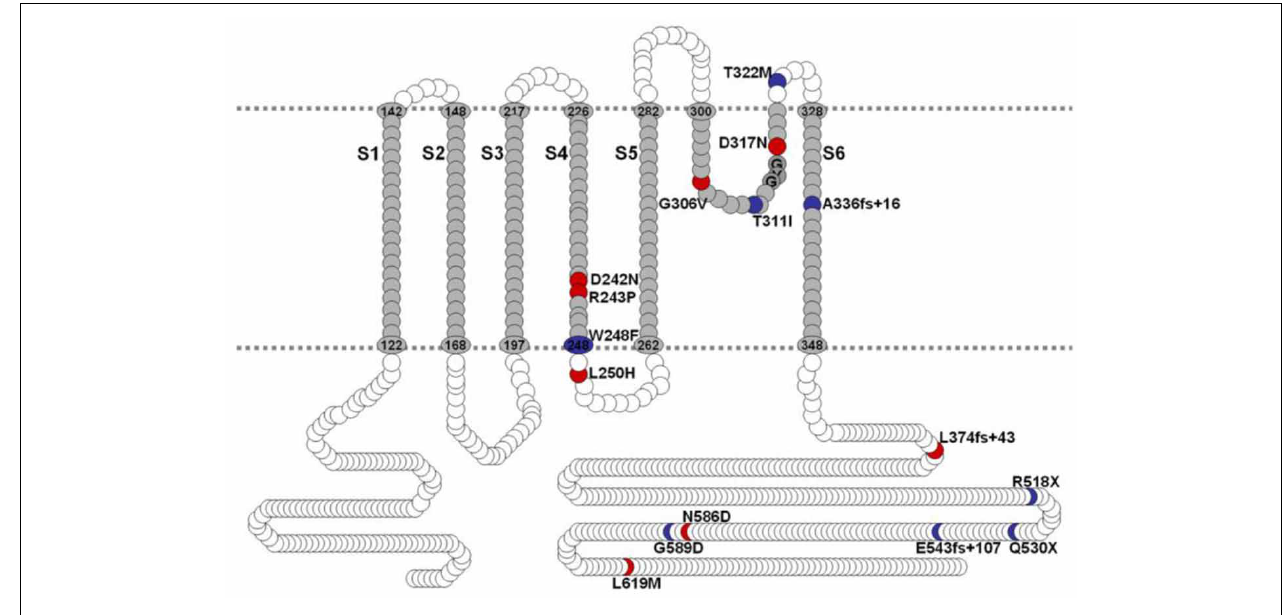
FIGURE 1 | Schematic diagram of hKv7.1. JLNS mutations are indicated in blue, RWS, mutations are indicated in red. Amino acid numbers in transmembrane domains and P-loop regions